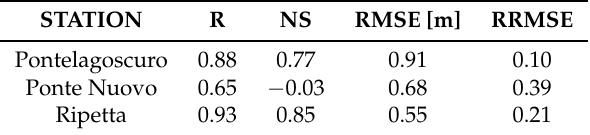
Table 3. Performance indicators of the simulated water levels versus the ground-based